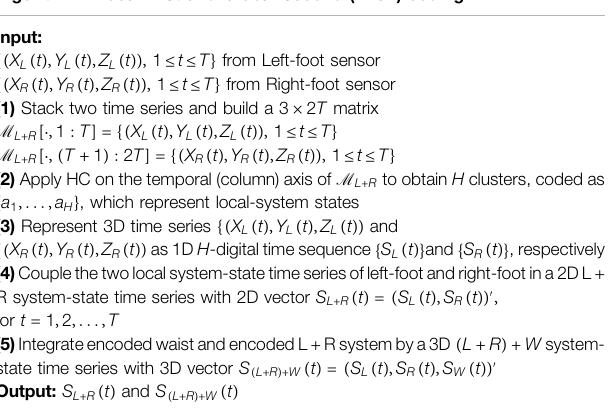
Algorithm1: Local- fi rst and Global-second (L1G2) coding